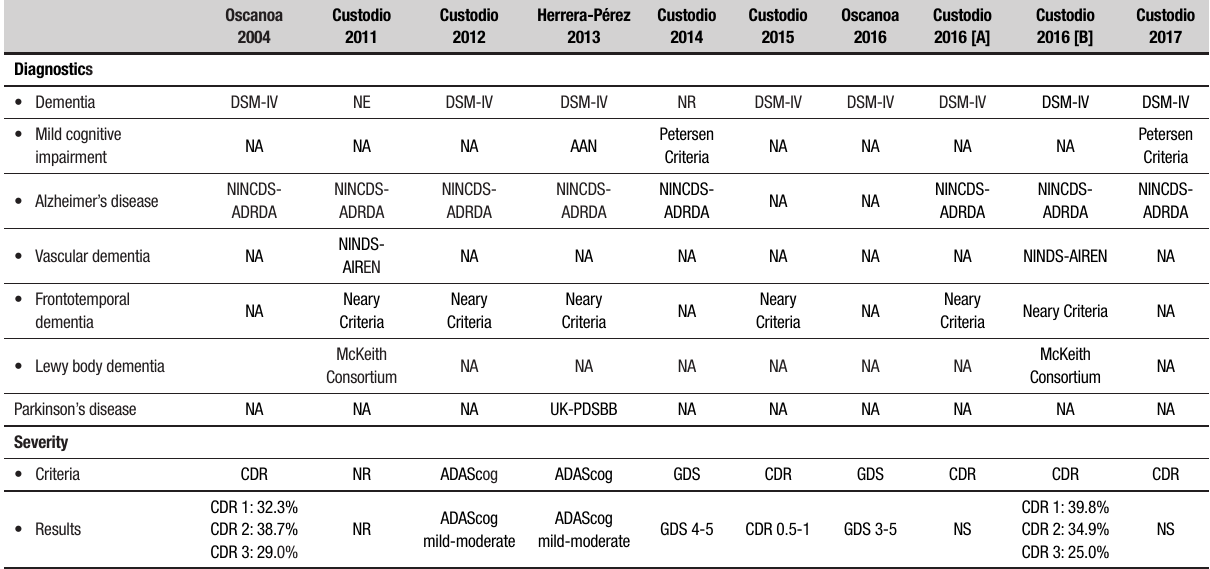
Table 4. Diagnosis and severity criteria applied in studies